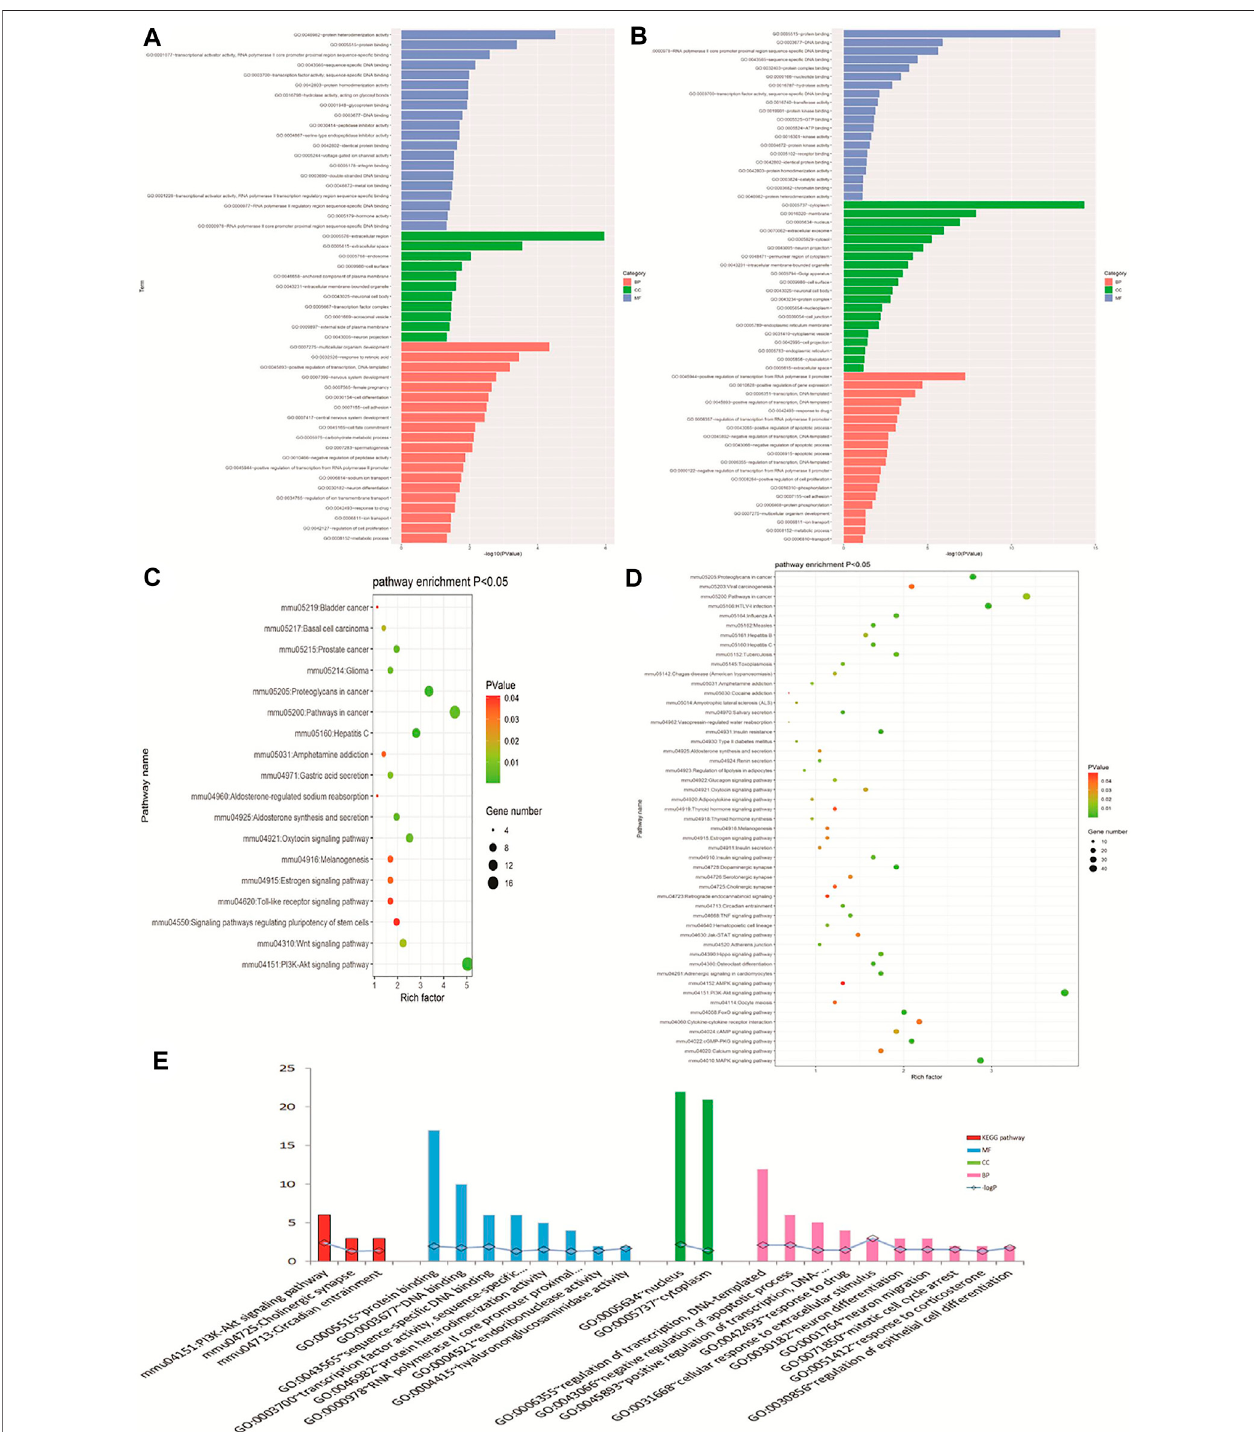
FIGURE 4 | Gene Ontology (GO) and Kyoto Encyclopedia of Genes and Genomes (KEGG) pathway analyses. GO analysis of DEGs with opioid (A) and ATS treatments (B) . KEGG pathway enrichment analysis for DEGs in opioid (C) and ATS treatments (D) . GO and KEGG pathway analysis for CDEGs (E) .